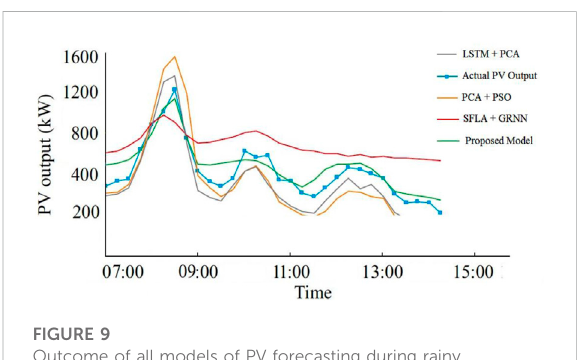
FIGURE 9 Outcome of all models of PV forecasting during rainy Conditions.